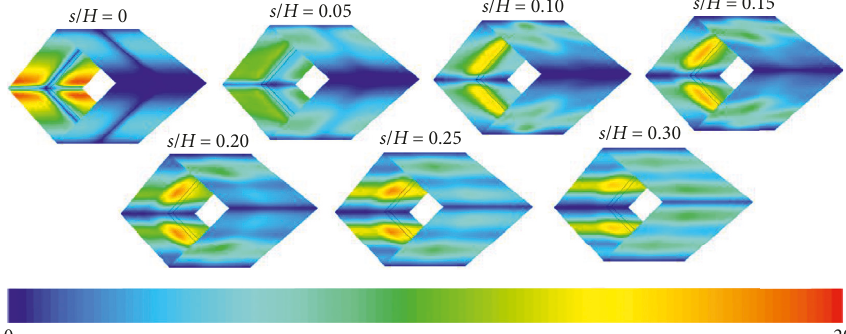
Figure 10: Nu x of the heat exchanger square duct installed with the 45